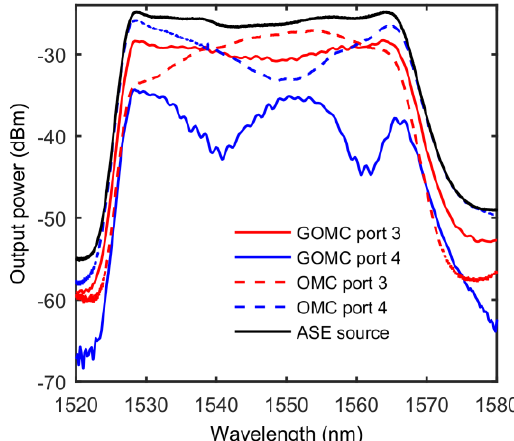
Figure 2. The transmission spectrum of the optical microfiber coupler (OMC) and the graphite- Figure2. Thetransmissionspectrumoftheopticalmicrofibercoupler(OMC)andthegraphite-integrated integrated OMC (GOMC) sample. ASE: Amplified Spontaneous Emission. OMC (GOMC) sample. ASE: Amplified Spontaneous